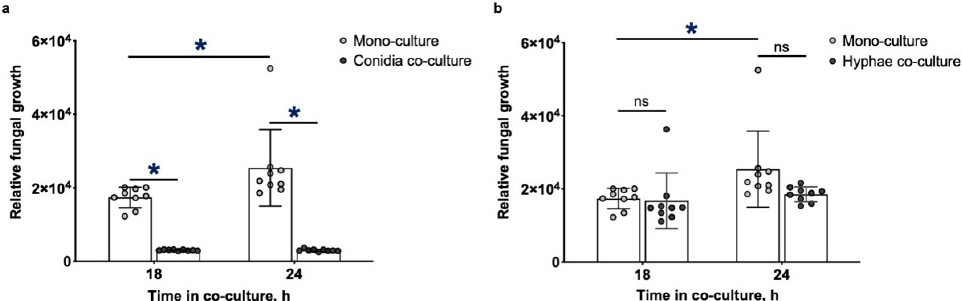
( b ) growth of A. fumigatus pre-grown hyphae in co-culture with P. aeruginosa was monitored by quantifying relative galactomannan (GM) over time using a GM enzyme immunoassay (EIA). Bars represent the means ± standard deviations of 3 independent experiments. A significant increase in growth is indicated by * ( p < 0.05) and no significant difference in growth is indicated by ns as de- termined by unpaired t